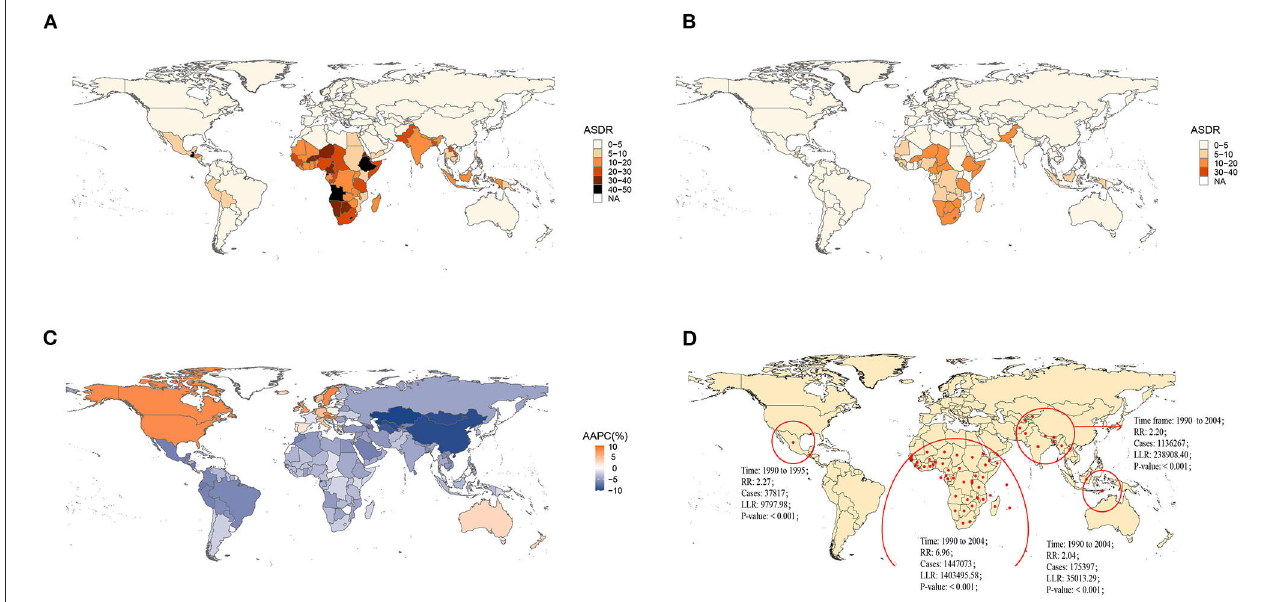
FIGURE 1 | Global burden of norovirus-associated diseases (NADs) in 1990 and 2019 with the annual percent change rate and spatial and temporal aggregation over the 30 years. (A) Age-standardized death rate (ASDR) in 1990; (B) ASDR in 2019; (C) average annual percent changes (AAPCs) from 1990 to 2019; (D) Spatial and temporal aggregation from 1990 to